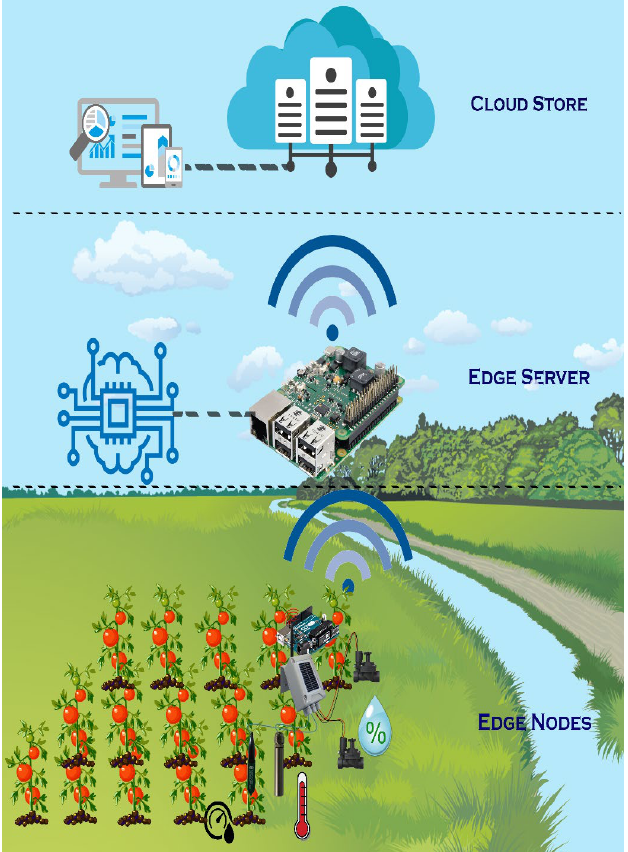
Figure 6. Edge Computing scenario for intelligent